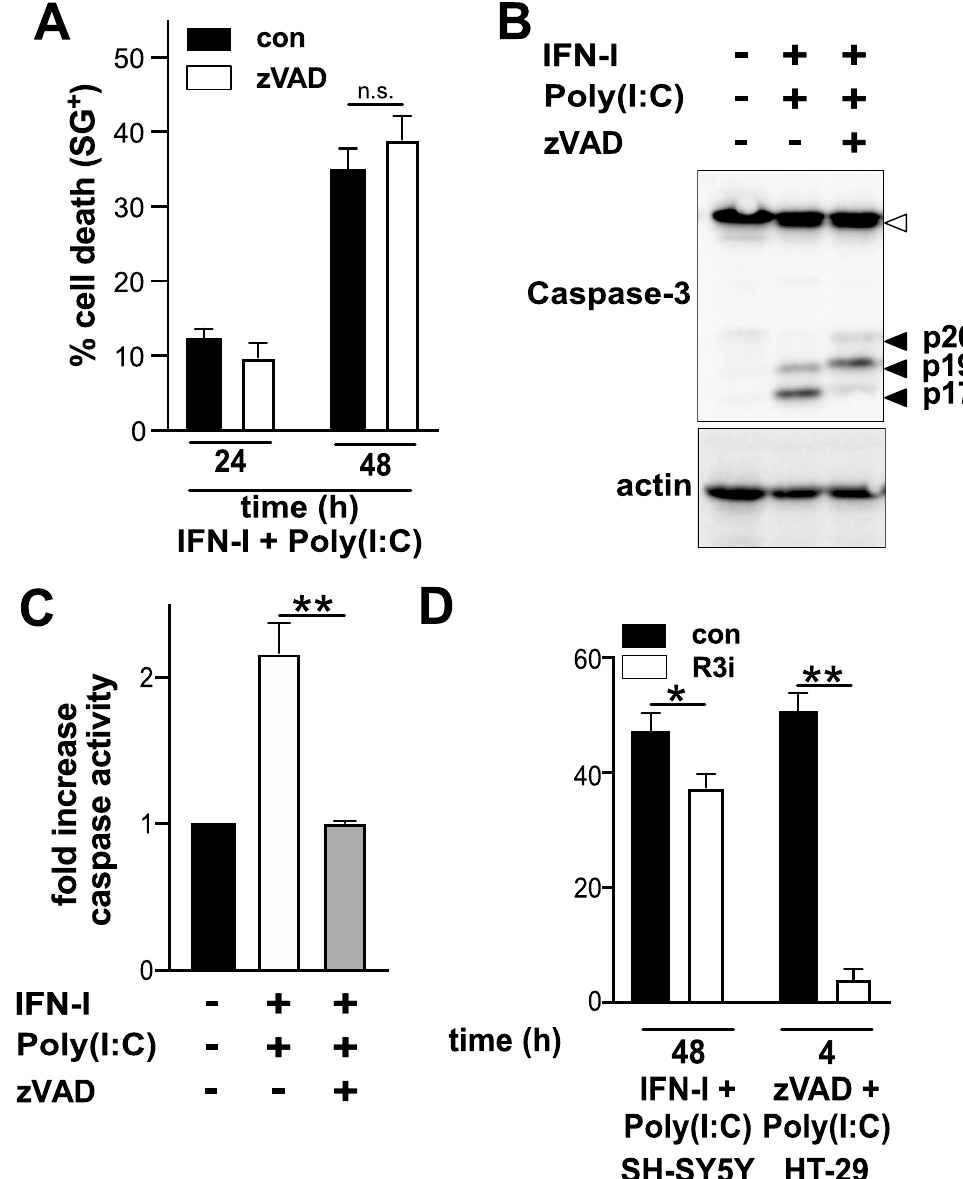
Figure 3. TLR3-induced cell death does not resemble extrinsic apoptosis nor necroptosis. ( A ) Cell death profile of SH-SY5Y cells pretreated with 25 µM zVAD followed by IFN-I/Poly(I:C) treatment. Cell death was determined by SG positivity and data points represent the mean ± S.E.M. of n = 3; non significant (n.s.) ( B ) Caspase-3 cleavage of SH-SY5Y cells pre-treated with 25 µM zVAD followed by treatment for 48 h with IFN-I/ Poly(I:C). Caspase-3 pro-forms are indicated by an empty arrowhead, while the cleavage products are indicated by solid black arrowheads. Actin was used as a loading control. ( C) Caspase-enzymatic activity determined by fluorescence signal emitted due to enzymatic cleavage of Caspase specific substrate DEVD-AFC. The inhibitory effect of 25 µM zVAD concentrations is displayed as fold decrease of the fluorescence signal obtained in SH-SY5Y treated with IFN-1/Poly(I:C) for 48 h. Data points represent the mean ± S.E.M. of at four independent experiments. **p < 0.001 ( D ) Cell death profile of SH-SY5Y cells pre-treated with the RIPK3 inhibitor GSK’872 (R3i) followed by treatment with IFN-I/Poly(I:C). Cell death was determined by SG uptake. Data points represent the mean ± S.E.M. of three independent experiments. HT-29 cells treated with Poly(I:C), BV6 and zVAD were used as positive control of necroptosis induction. *p < 0.05, **p <